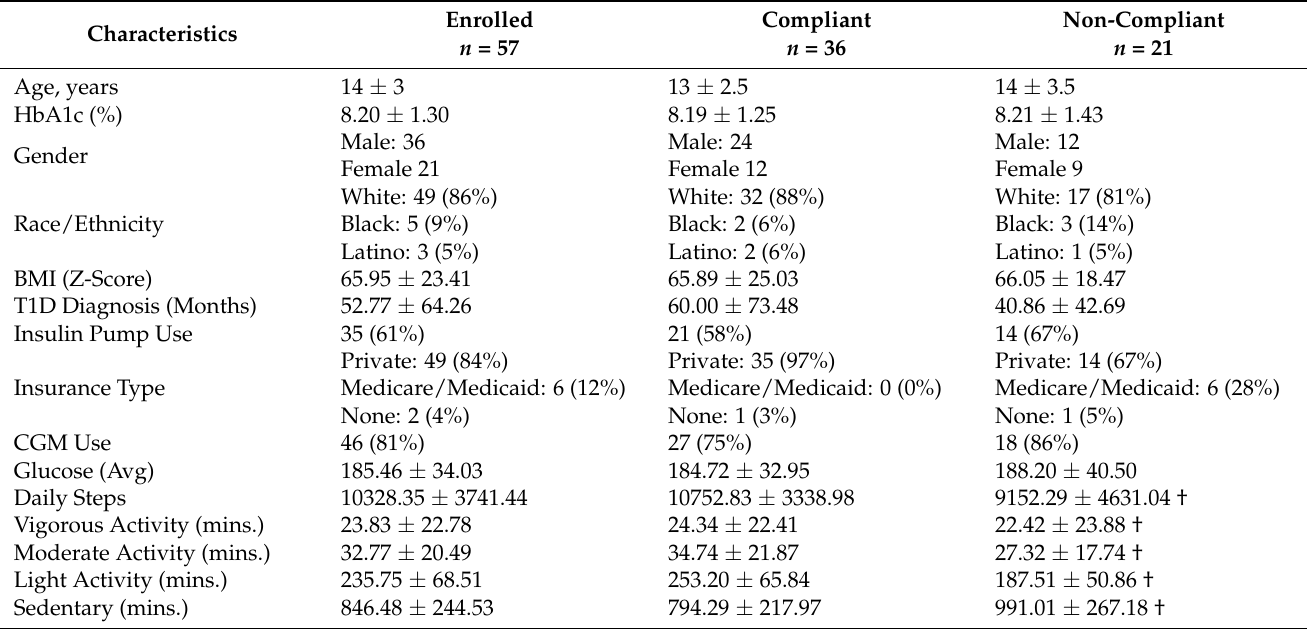
Table 1. Demographic characteristics for all participants and separated by compliancy.